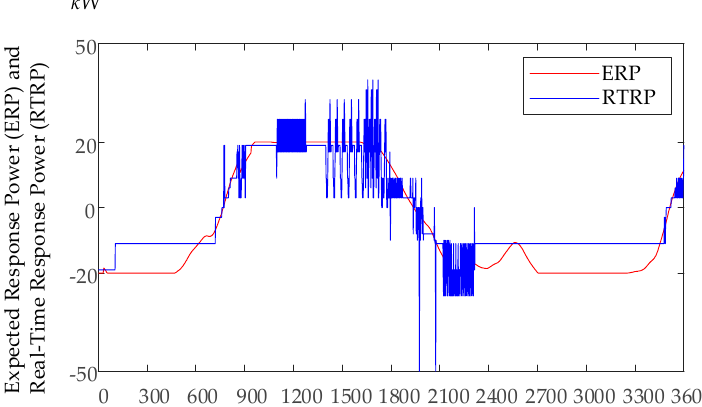
Figure 4. The expected and real-time AGC response power of the flow shop.